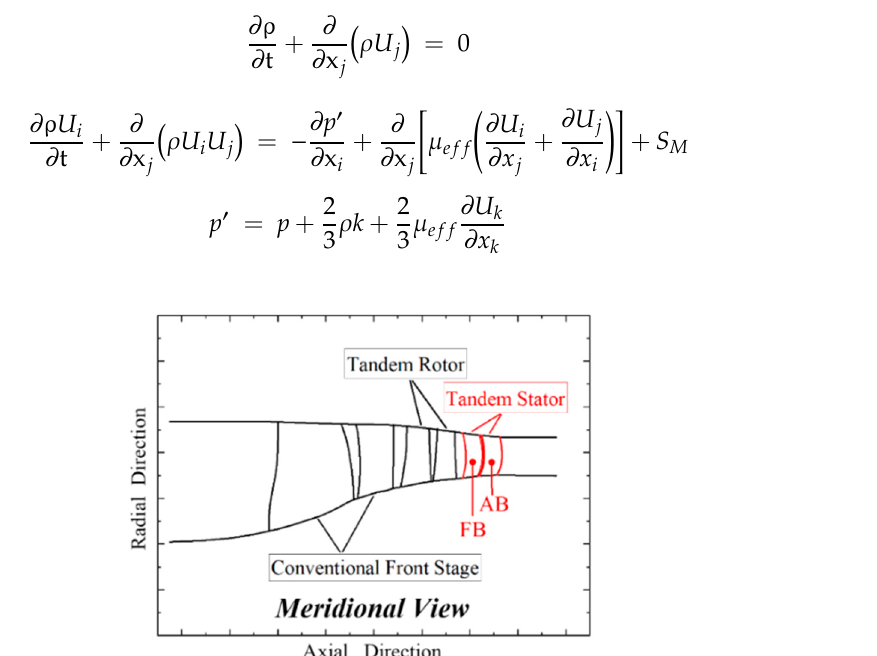
Figure 2. Configuration of the double-stage compressor with tandem blades.